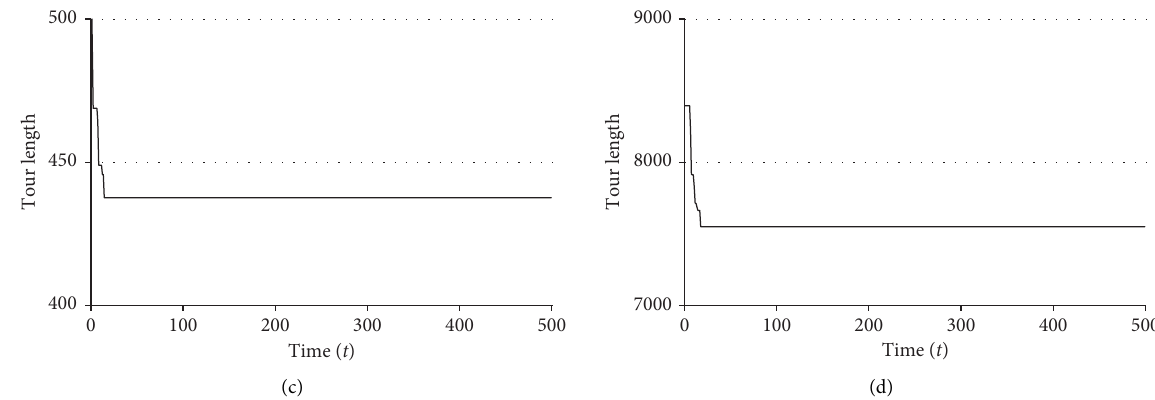
Figure 2: Best solution update in AS rank . (a) bayg29. (b) att48. (c) eil51. (d) berlin52.